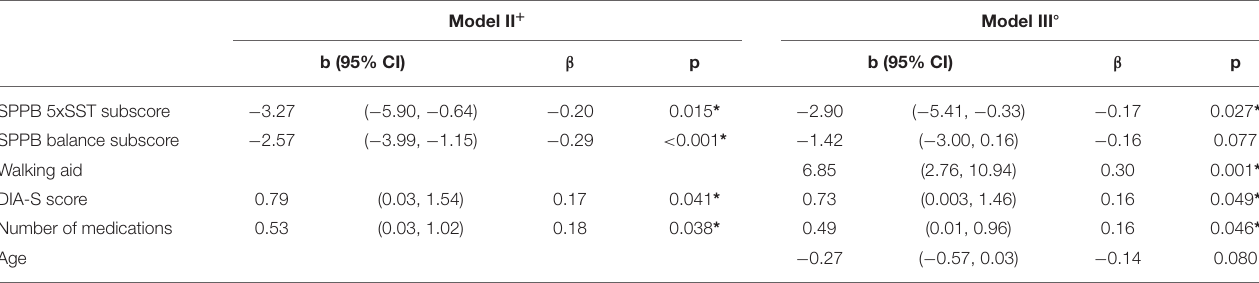
TABLE 4 | Multiple regression analyses including SPPB subscores with FES-I score as dependent variable (with and without including the use of a walking aid as independent